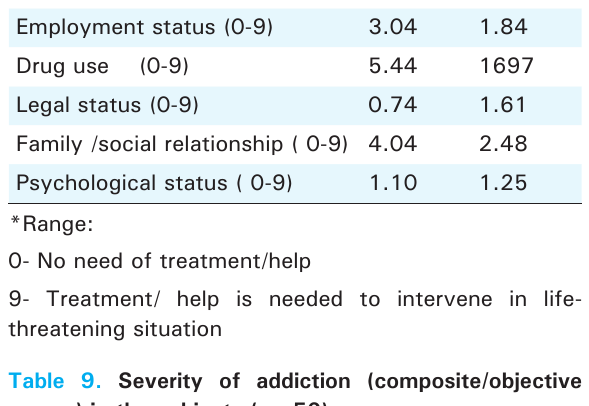
Table 9. Severity of addiction (composite/objective